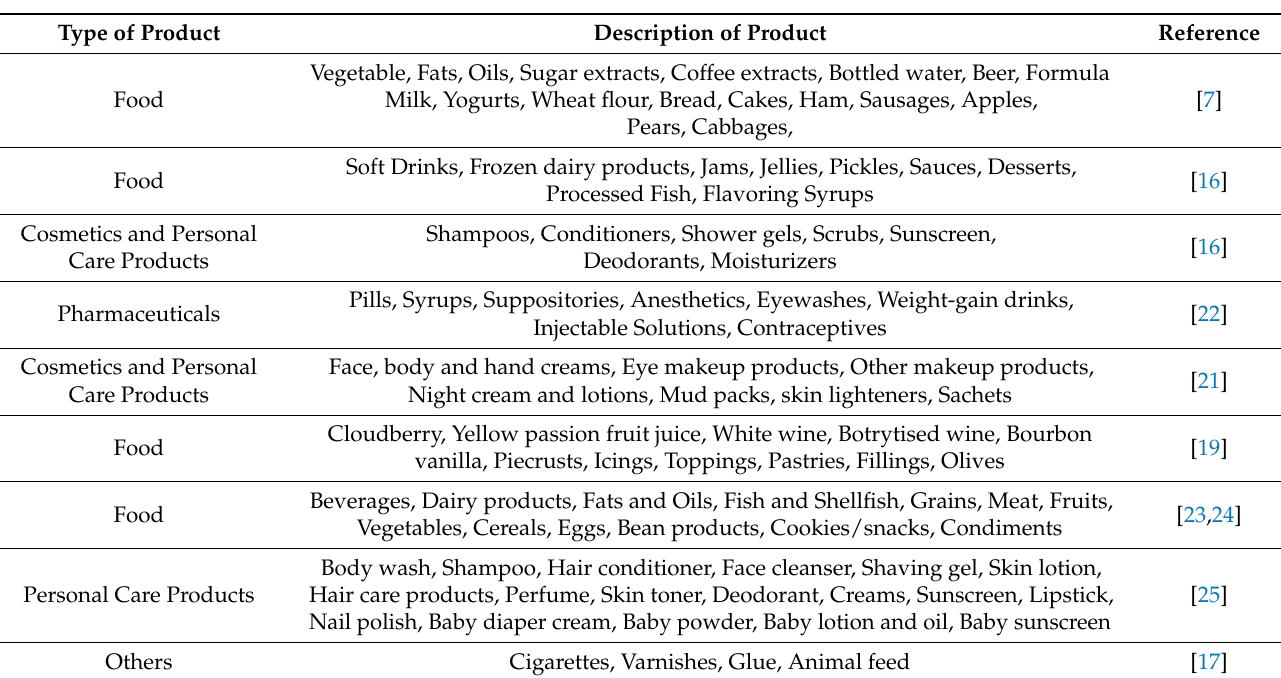
Table 2. Types of products with parabens